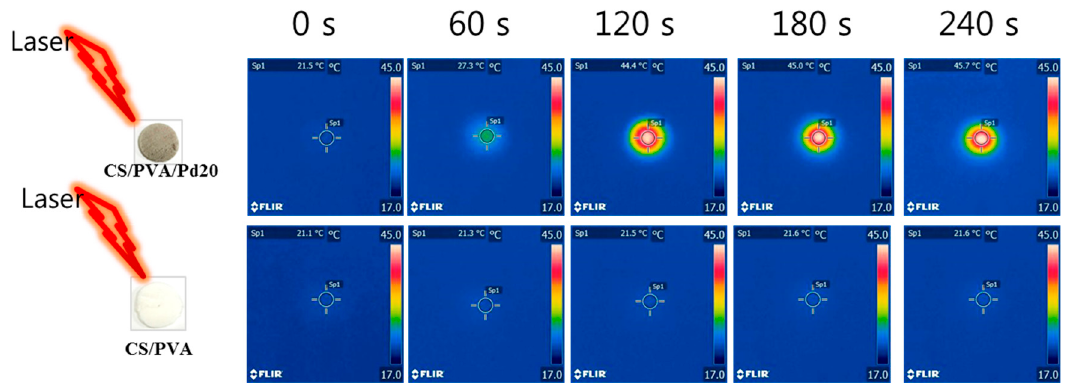
Figure 7. Thermal images of CS/PVA/Pd20 and CS/PVA under laser irradiation (240 s, 1 W/cm²).